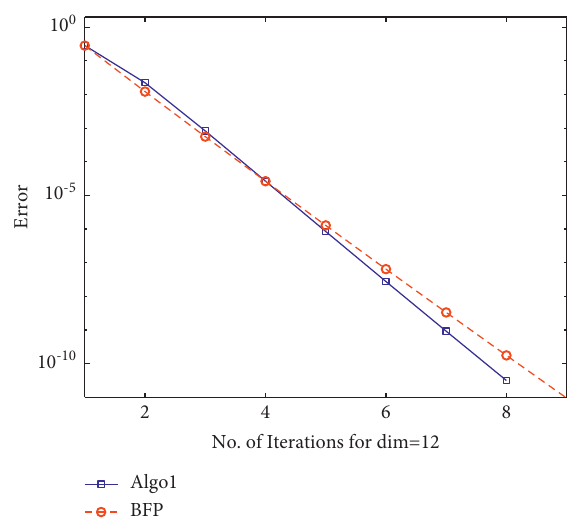
Figure 15: Iteration no. vs error for dimension